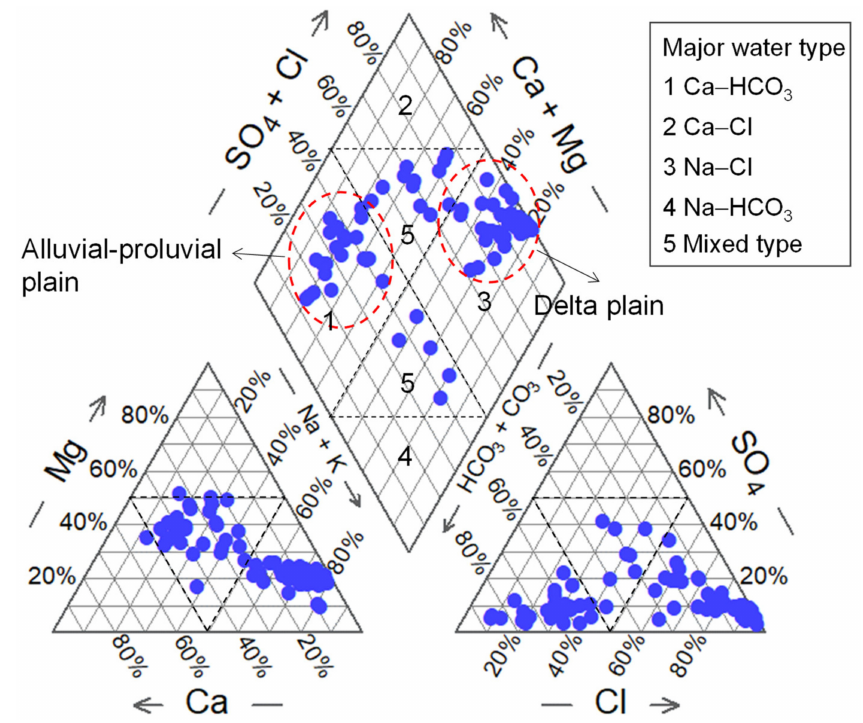
Figure 4. Piper plot of